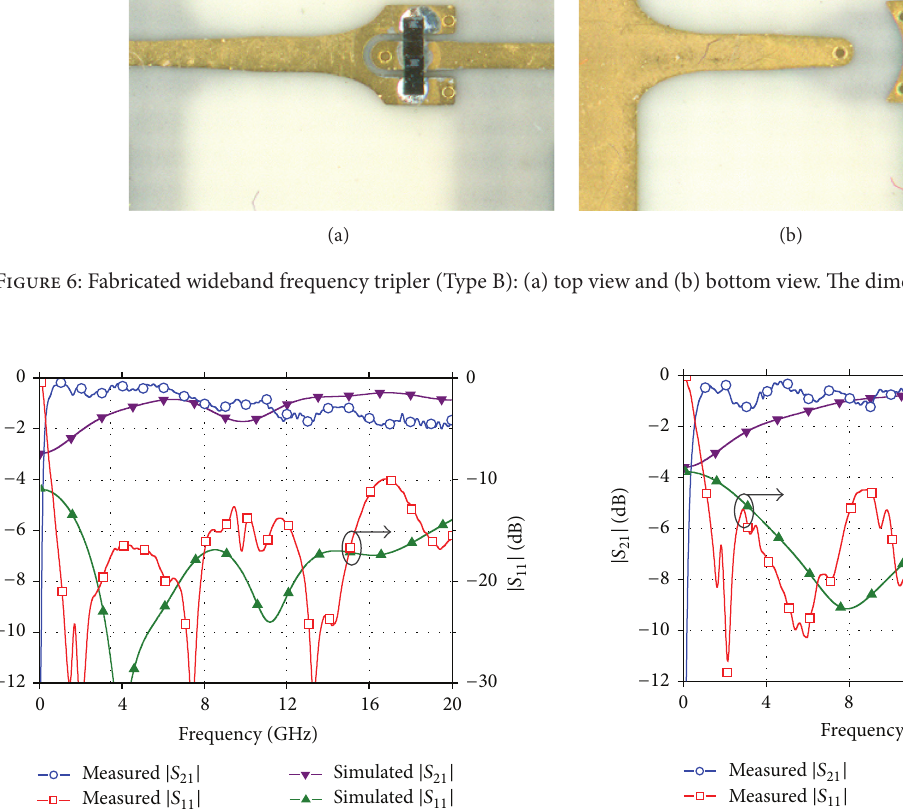
Figure 8: Simulated and measured performance of the Type B tran- sition.